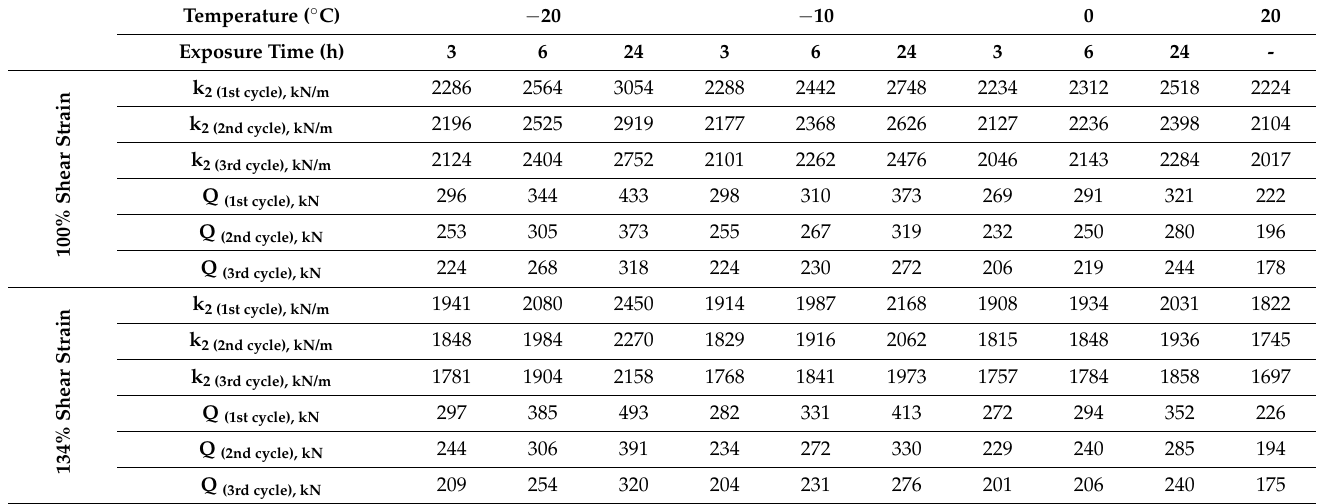
Figure 9. ( a ) Idealized bilinear force-displacement relation of LRB ( b ) application of LSM method. Table 2. Mechanical properties of LRB computed at the frequency of 0.1 Hz.